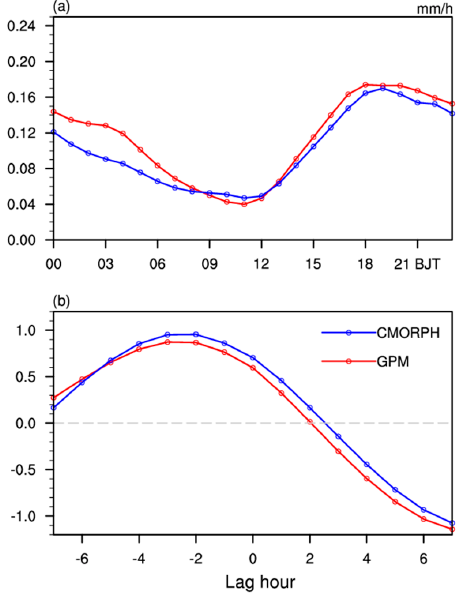
Figure 9. ( a ) Diurnal cycle of the TP precipitation rate (units: mm h − 1 ). ( b ) Lead − lag correlation